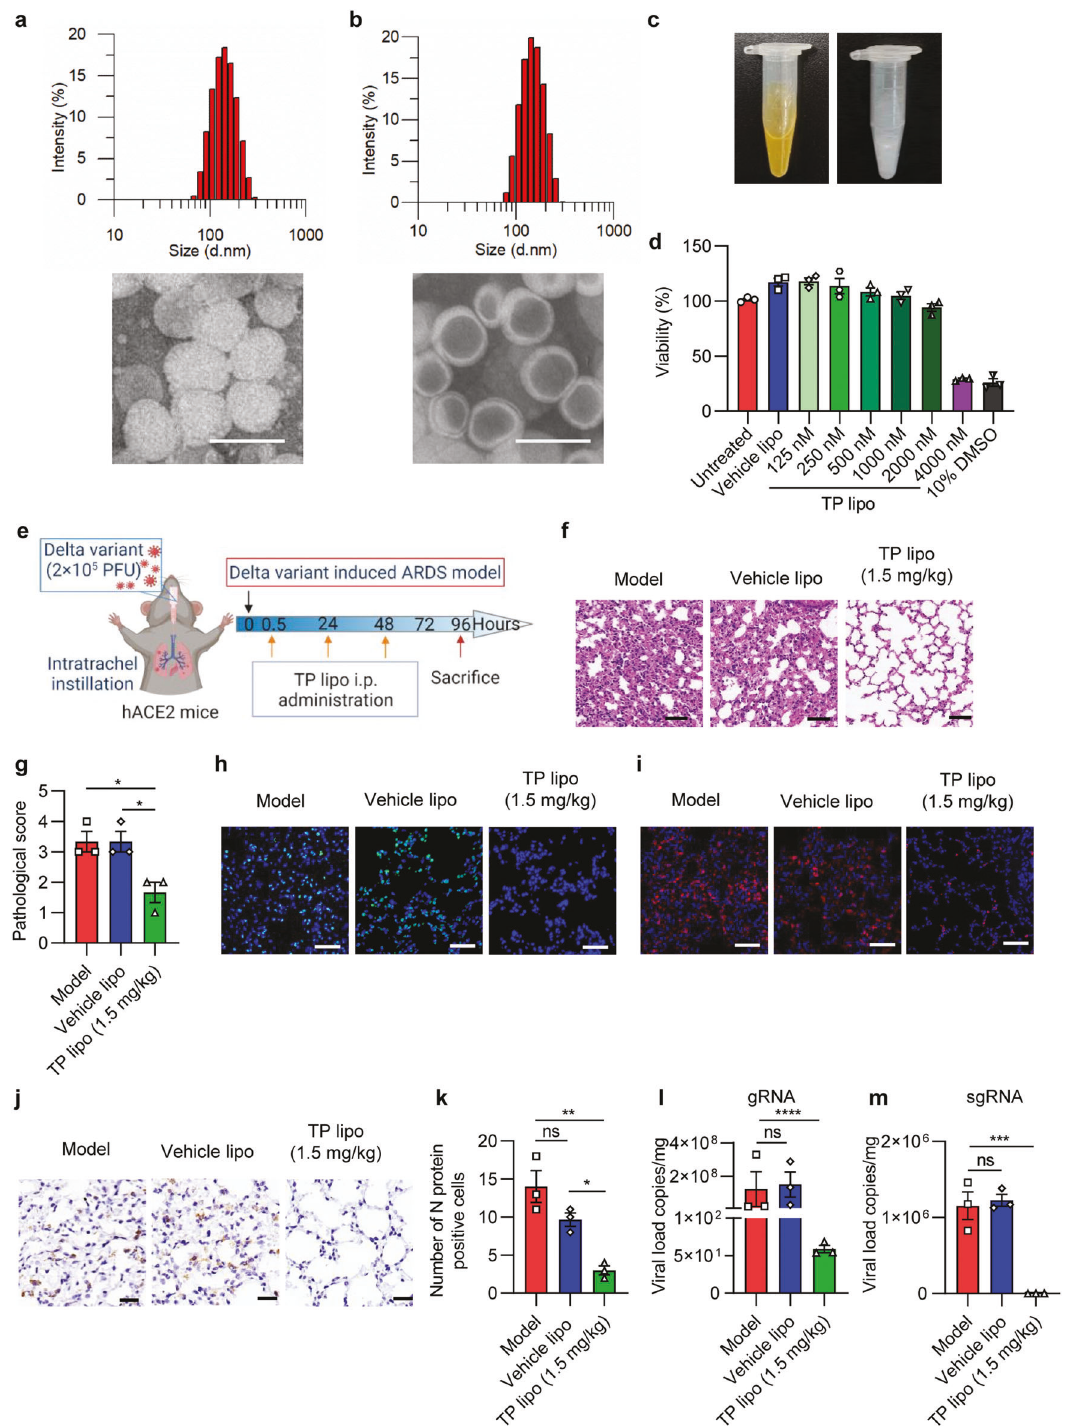
Fig. 1 In vitro and in vivo characterizations of TP lipo. a , b Hydrodynamic diameter of TP lipo ( a ) and Vehicle lipo ( b ), measured from DLS. TEM images of TP lipo ( a ) and Vehicle lipo ( b ). The scale bar represents 200 nm. c Photographs of TP lipo (left) and Vehicle lipo (right). d Cell viability of Vero E6 cells in fl uenced by Vehicle lipo, TP lipo at different concentrations, and 10% DMSO. e Protocol of the hACE2 mouse model of ARDS induced by the Delta variant. H&E staining ( f ) and pathological score ( g ) in representative mouse lung sections. The scale bar represents 50 μ m. h Images of TUNEL labeling for cell apoptosis analysis. The scale bar represents 50 μ m. i Typical images of immuno fl uorescence analysis for Ly6G-positive neutrophils. The scale bar represents 50 μ m. j Immunohistochemical staining of nucleocapsid (N) protein in the lungs of Delta variant-infected hACE2 mice. k Histogram of the number of N proteins in representative mouse lung sections. qRT-PCR quanti fi cation of Delta variant gRNA ( l ) and sgRNA ( m ) in infected mice with or without TP lipo treatment. Data represent the mean ± SEM; n = 3. Signi fi cance is indicated by: ns no signi fi cance; * P ≤ 0.05; ** P ≤ 0.01; *** P ≤ 0.005; **** P ≤ 0.0001